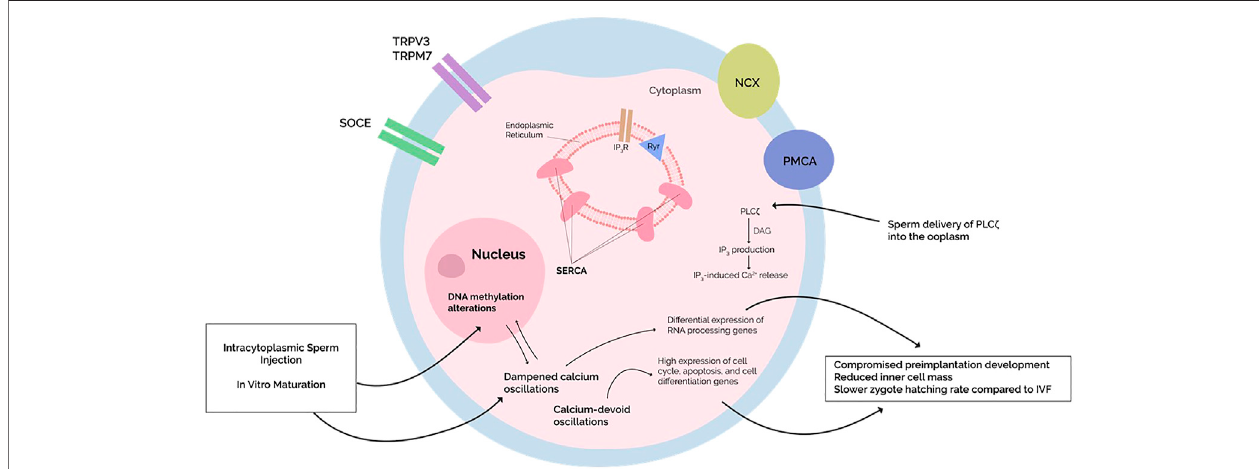
FIGURE 1 | Dampening or absence of calcium oscillations is seen in intracytoplasmic sperm injection (ICSI) and cycloheximide-induced oocyte activation, respectively. This alters embryonic development by altering gene expression. The molecular mechanisms behind such changes, however, remain unknown. Since an increasedriskofepigeneticdefectsisperceivedinISCIwithsimultaneouschangesinDNAmethylationpatterns,perhapstheDNAmethylationalterationsanddifferential geneexpressionareduetothedampenedoscillationssincemajorepigeneticprocessesoccurimmediatelyafterthecessationofcalciumoscillations.Alternatively, primary dysregulations in the oocyte DNA methylome — as induced by ICSI or in vitro maturation — may affect calcium homeostasis, although further studies need to be conducted.